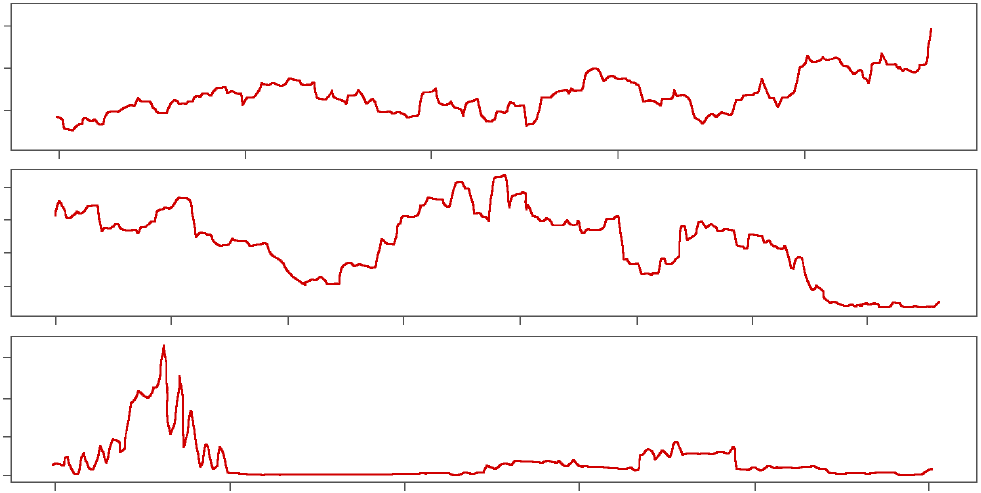
Figure 2. Normalised periodicity intensity from three sample ARC trial participants for a three-month duration. The frequency is 24 h, the window size is 7 days, and the window shift is 1 h. x -axis values span 3 months, and y -axis values have been normalised to the range 0 to